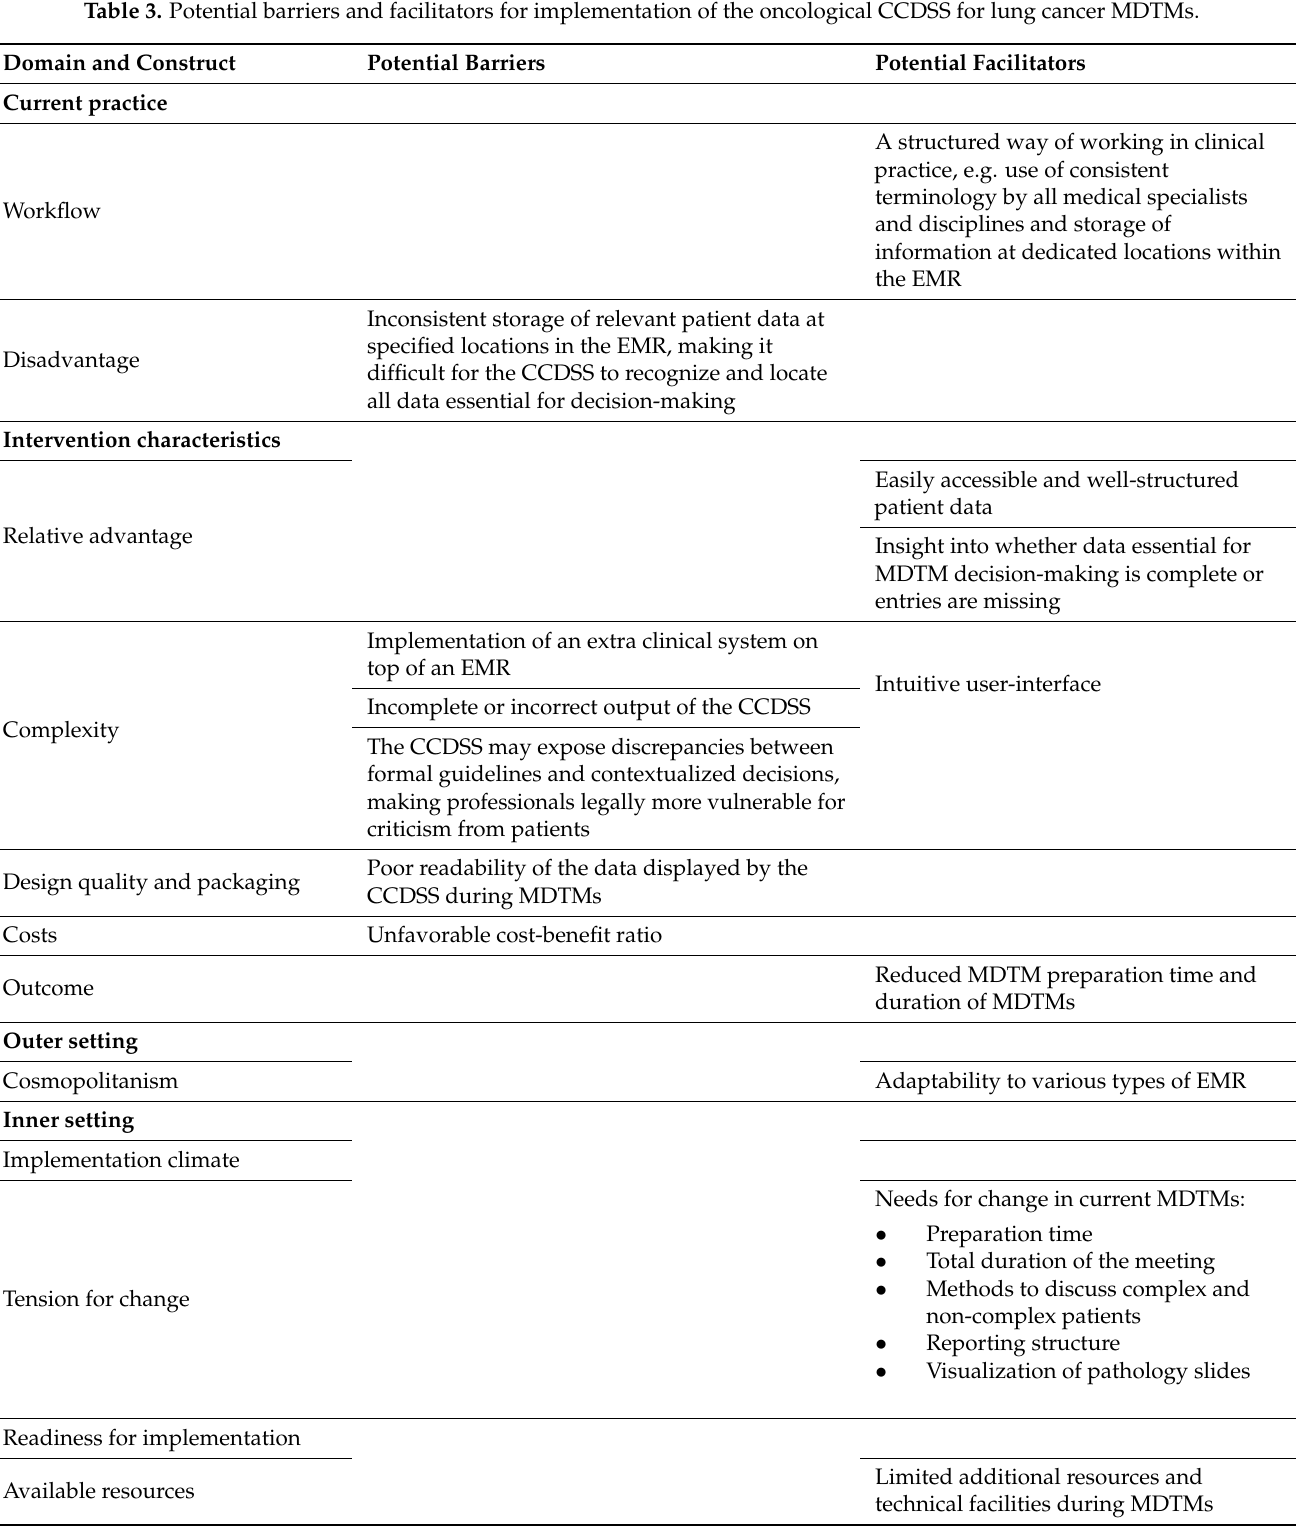
Table 3. Potential barriers and facilitators for implementation of the oncological CCDSS for lung cancer